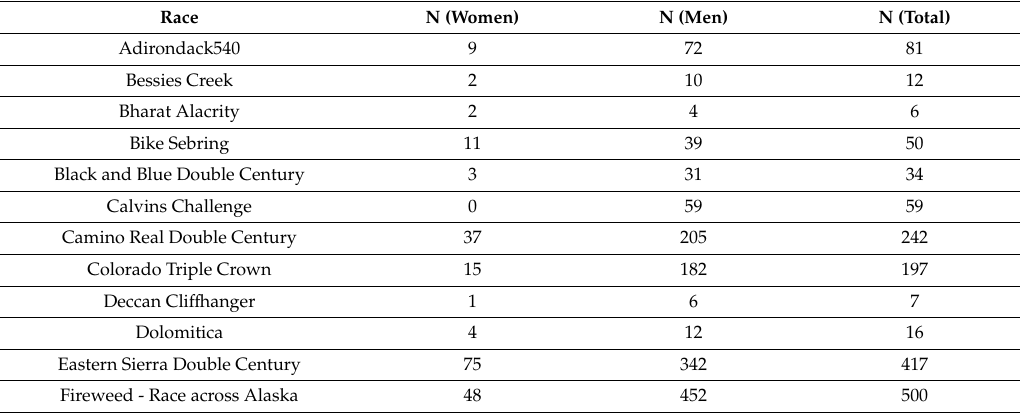
Table A1. Supplemental table with all included distance-limited ultra-cycling